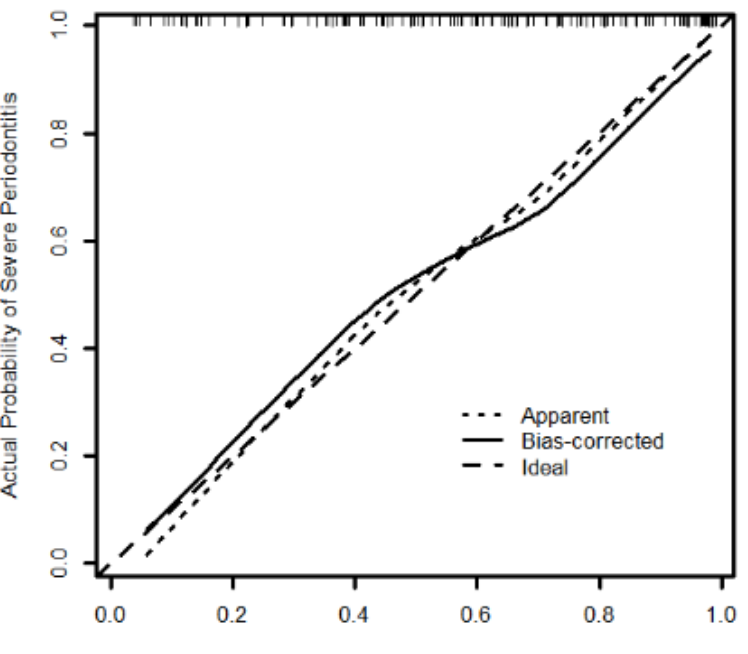
Figure 3. Calibration curves for AIC Selected Model (intercept = 0.026, slope = 0.834). The diagonal dotted line represents a perfect prediction by an ideal model. The solid line represents the performance of the nomogram, for which a closer fit to the diagonal dotted line represents a better prediction. (AIC: Aikaike information criterion).